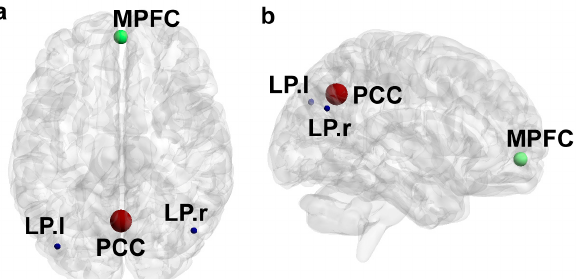
Figure 1. Glass brain schematic of the default mode network (DMN) endpoints ( a ) Dorsal view of the medial prefrontal cortex (MPFC, green), posterior cingulate cortex (PCC, red), left lateral parietal (LP.l, blue), and right lateral parietal (LP.r, blue) regions. ( b ) Lateral view of the MPFC (green), PCC (red), left lateral parietal (blue), and right lateral parietal (blue) regions.